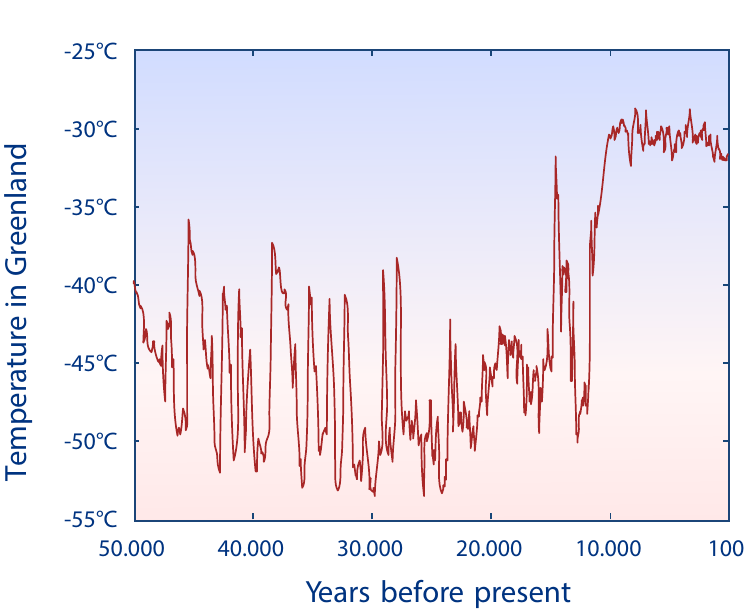
Fig. 3. – Fluctuations of the temperature in Greenland over the past 50000 years, from the GISP2 ice